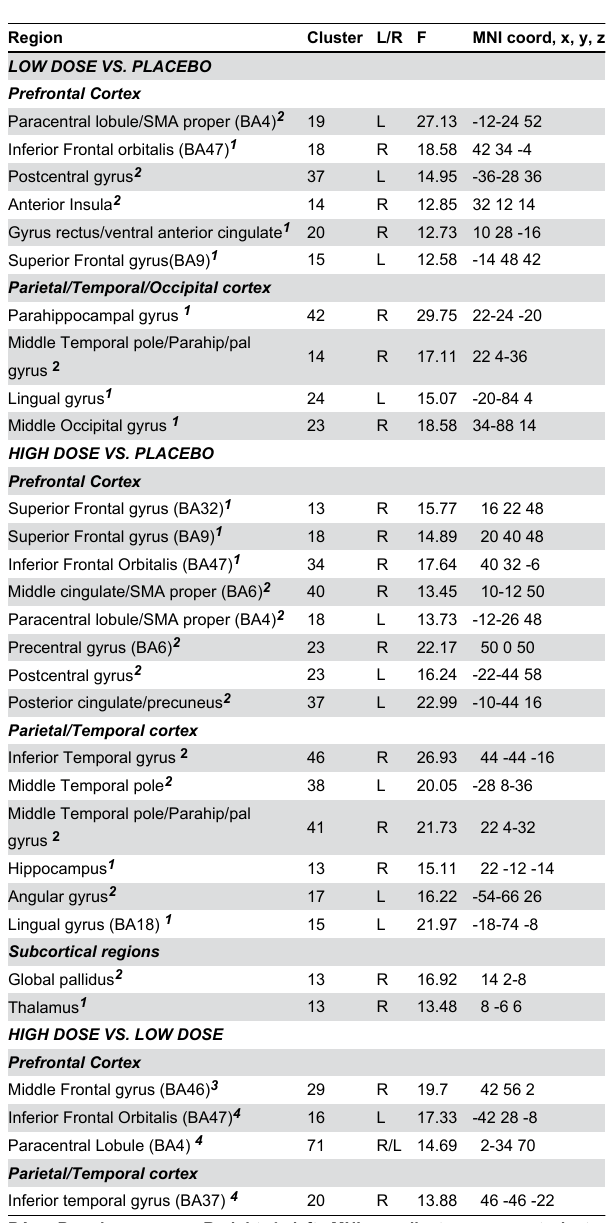
Table 7. Activations resulting from the Sstop>Go contrast group comparisons (p <.005, k ≥ 13